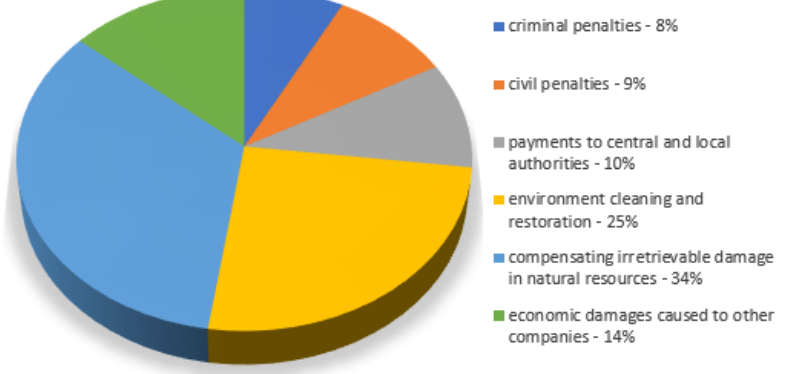
Figure 4. Deep Horizon percentual costs by